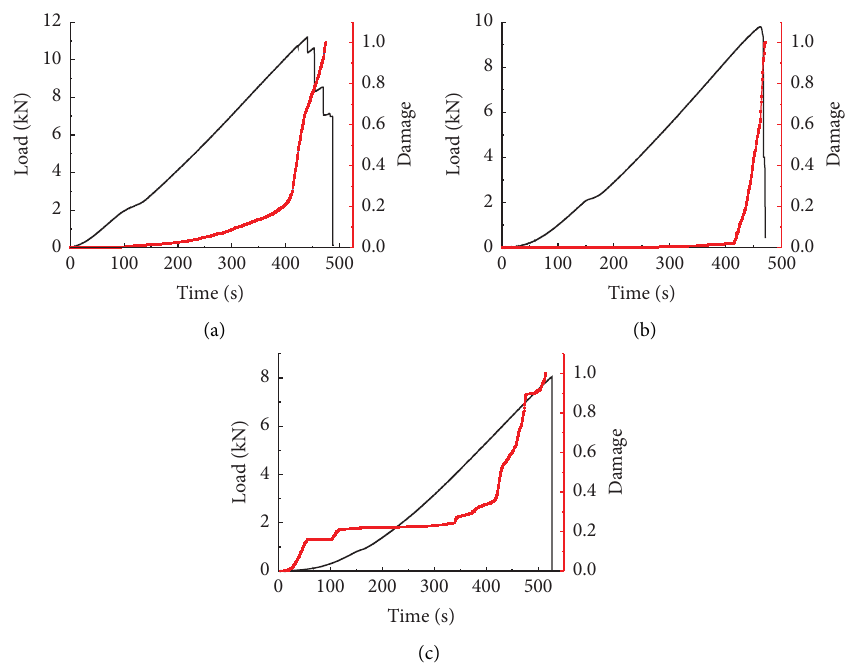
Figure 6: Evolution of coal sample damage: (a) N1; (b) NF1; (c)